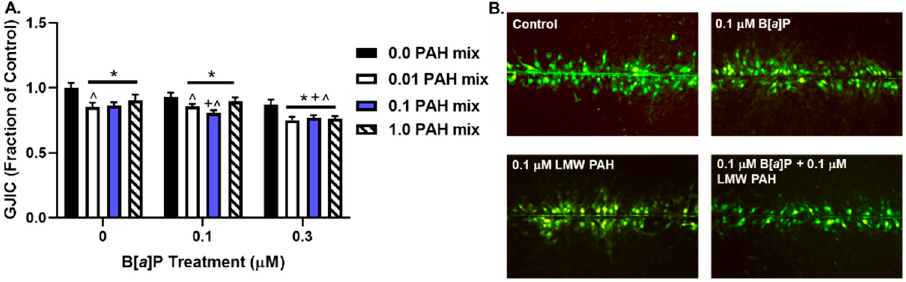
Figure 4. GJIC dysregulation in BEAS-2B cells exposed to PAHs. GJIC in BEAS-2B cells exposed to 0.01, 0.1, or 1 µ M of the LMW PAHs and either 0.1 µ M B[ a ]P or 0.3 µ M B[ a ]P alone or in combination with the LMW PAHs. ( A ) Bars represent the mean ± SEM, as a percentage of GJIC exposed to control (DMSO); (n = 3) per treatment; repeated three times * p < 0.05, significantly different from control; + p < 0.05, significantly different from LMW PAHs; ^ significantly different from B[ a ]P. ( B ) Representative images of GJIC dysfunction in response to either control (DMSO), 0.1 µ M B[a]P, 1 µ M LMW PAHs, or a combination